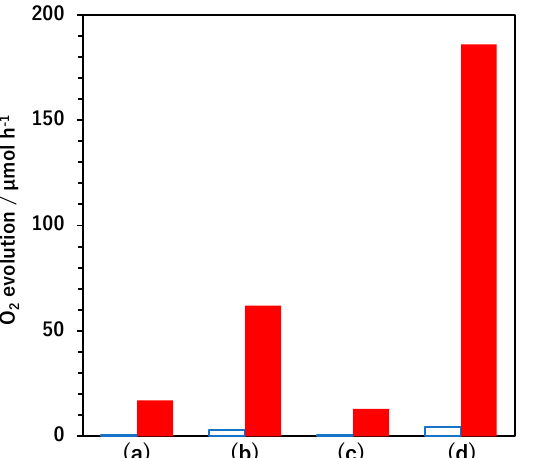
Figure 1. Oxygen evolution rates obtained from BaTaO 2 N (unfilled) and BaTaO 2 N:Mg (filled) loaded with ( a ) no cocatalyst, ( b ) Pt (0.1 wt%) by impregnation–reduction, ( c ) FeO x (0.1 wt%) by photodeposition, and ( d ) Pt (0.1 wt%) by impregnation–reduction followed by FeO x (0.1 wt%) by photodeposition. Reaction conditions were as follows: photocatalyst, 0.2 g; distilled water, 120 mL; AgNO 3 , 10 mM; La 2 O 3 , 0.1 g; 300 W Xe lamp ( λ > 420 nm).